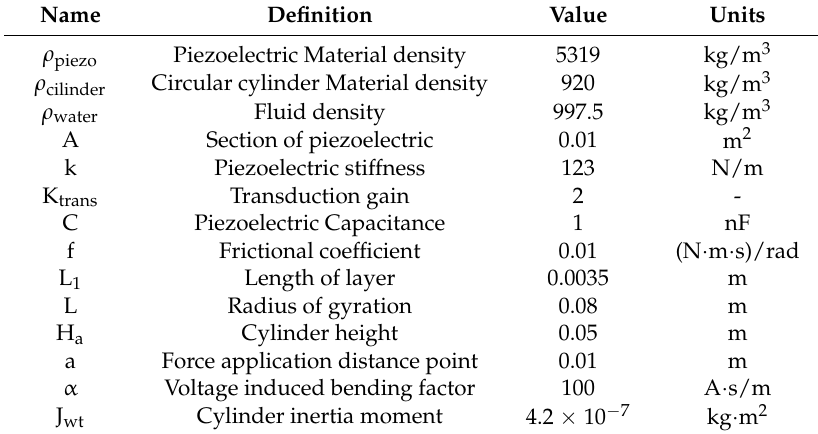
Table 2. Model parameters.